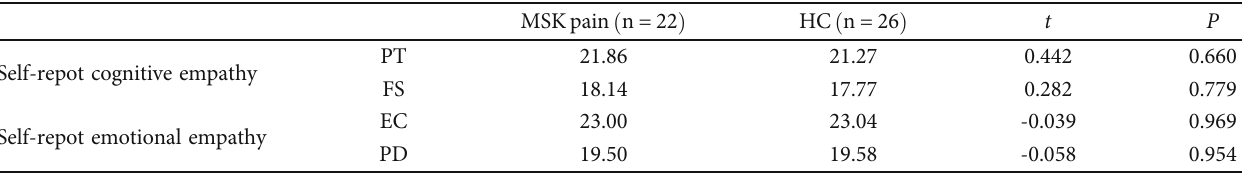
Table 3: IRI fantasy (FS), perspective taking (PT), empathic concern (EC), and personal distress (PD) subscale scores in chronic musculoskeletal pain (MSK pain) and healthy control (HC) groups. The perspective-taking and fantasy subscales represent self-report cognitive empathy, while the empathic concern and personal distress subscales represent self-report emotional